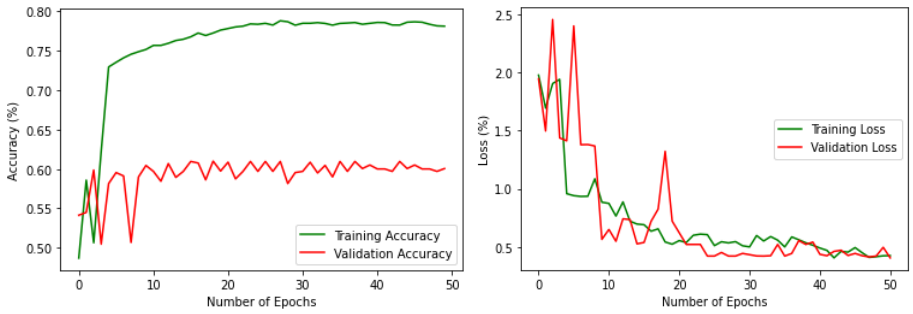
Figure 5. Accuracy and loss, respectively, for the processed data.